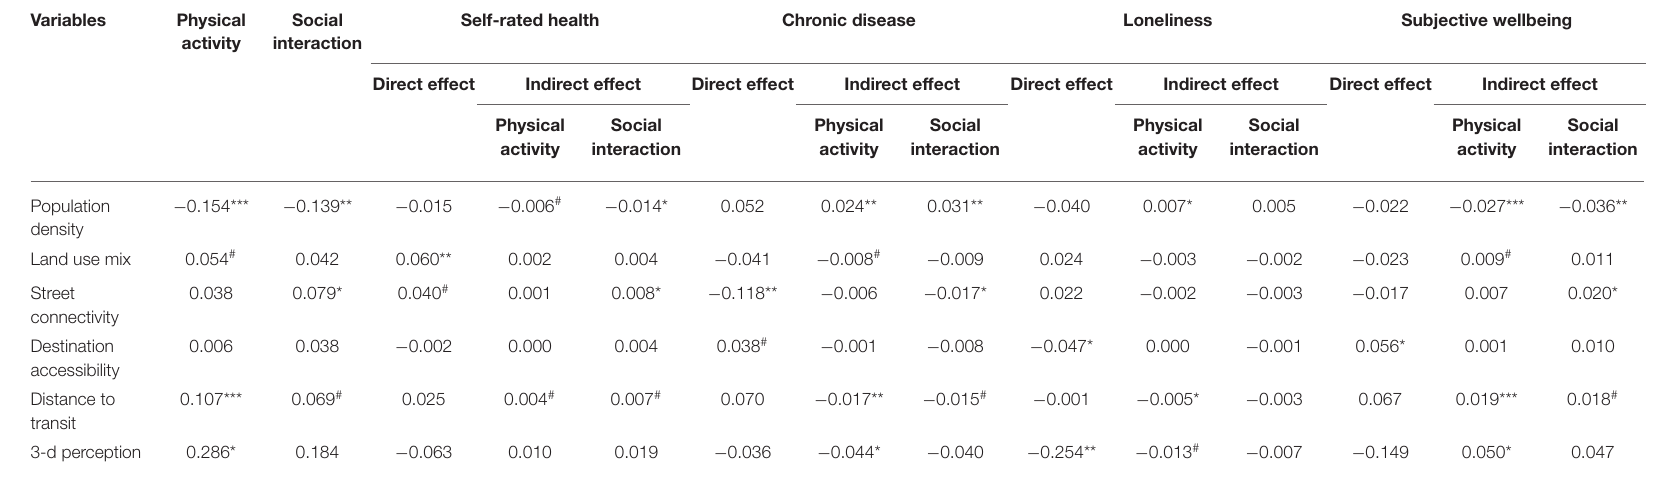
TABLE 5 | Statistical results of multilevel structural equation models (MSEMs) for the built environment and elderly health (full sample). Variables